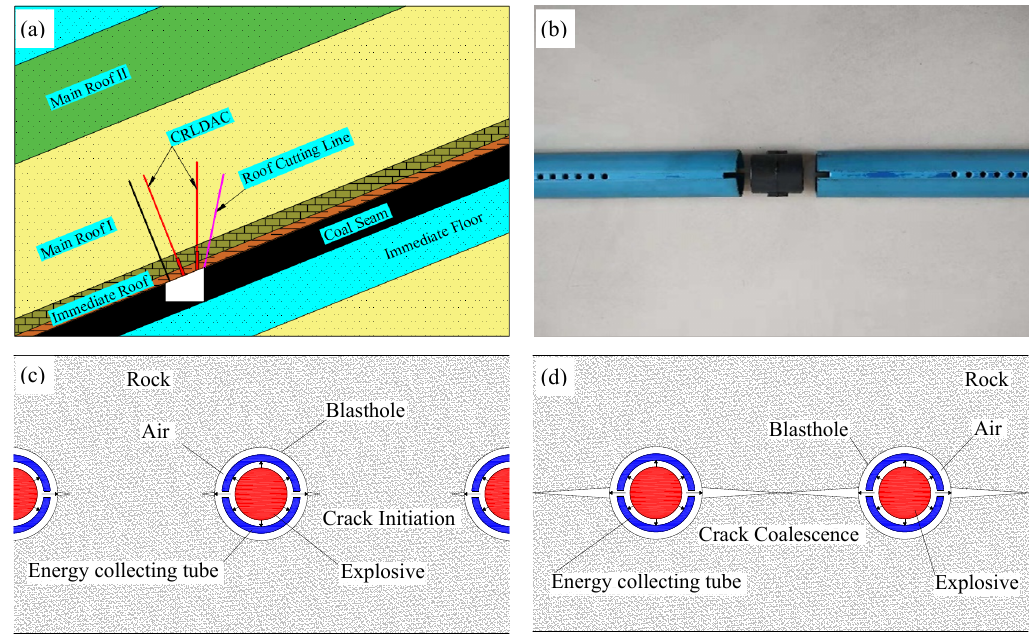
Figure 3. Directional presplit blasting device and principles: ( a ) directional presplit blasting technology (roof cutting line); ( b ) connection between energy collecting tubes; ( c ) initial crack after blasting; ( d ) coalescent crack after blasting.